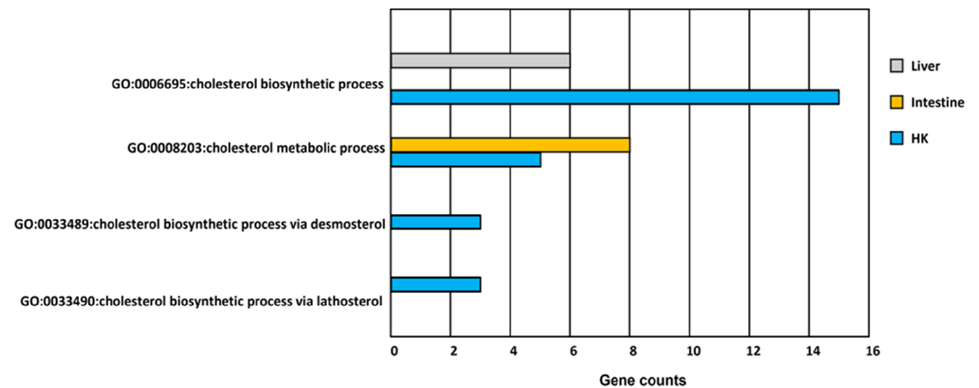
Figure 7. GO functions related to cholesterol metabolism in response to hypoxia in common carp organs. There are more than three genes involved in four cholesterol GO terms in the head kidney (HK). However, there is only one cholesterol GO term involved in the liver and the intestine.